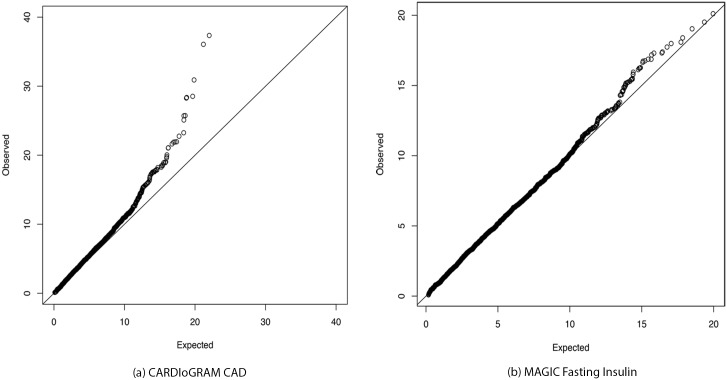
QQ plots of observed versus expected GenCAT test statistics.